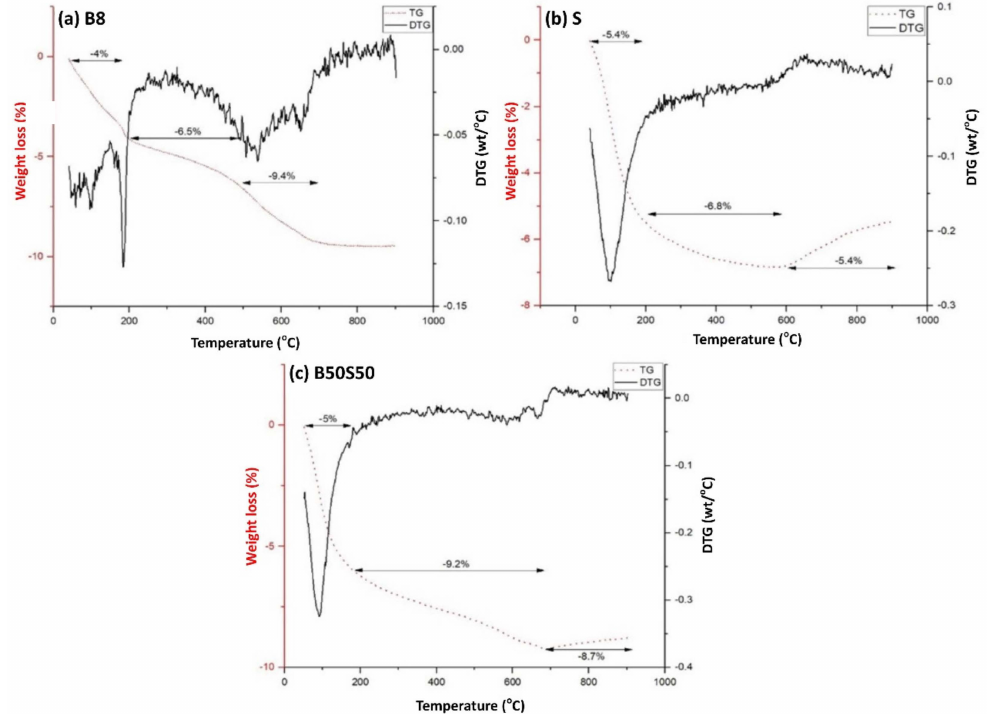
Figure 8. Thermogravimetric (TG) analysis of ( a ) a brick-based specimen (B8), ( b ) a slag-based specimen (S) and ( c ) the B50S50 IP under the optimum synthesis conditions (H 2 O / Na 2 O = 18.21, curing at 90 ◦ C and ageing for 7 days) (DTG: Derivative thermogravimetric analysis; it is the mass loss rate of sample in g min − 1 measured by TG